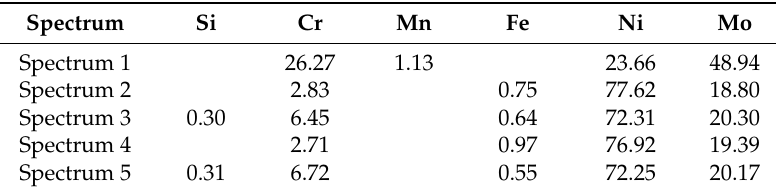
Table 6. Results of the EDX analysis (wt. %).